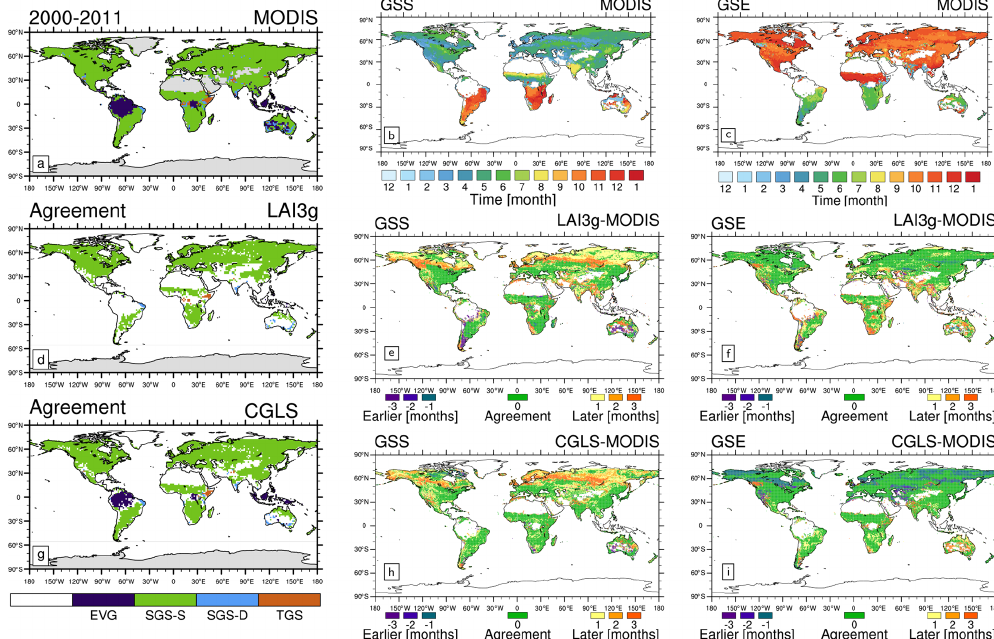
Figure 2. Global climatological (averaged over 2000–2011) distribution of (a) the four main growing season modes, (b) growing season start (GSS) timings, and (c) growing season end (GSE) timings for MODIS version 6. The other panels show the comparison between MODIS and LAI3g (second row) and CGLS (third row). In particular, panels (d) and (g) show the areas characterized by the same phenology types (d) between MODIS and LAI3g and (g) between MODIS and CGLS; panels (e) and (h) exhibit the difference in GSS timings; and panels (f) and (i) display the differences in GSE timings. In panels (d) and (g) white areas represent non-vegetated areas and regions of disagreement (d) between MODIS and LAI3g and (g) between MODIS and CGLS. White areas in panel (b) , (c) , (e) , (f) , (h) , and (i) show evergreen and non-vegetated